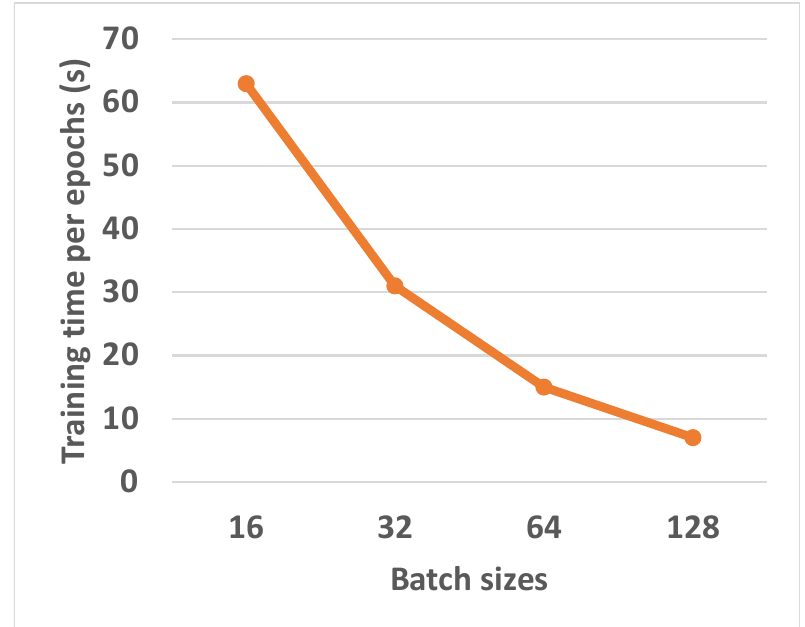
Figure 15. Computational cost vs. batch size.